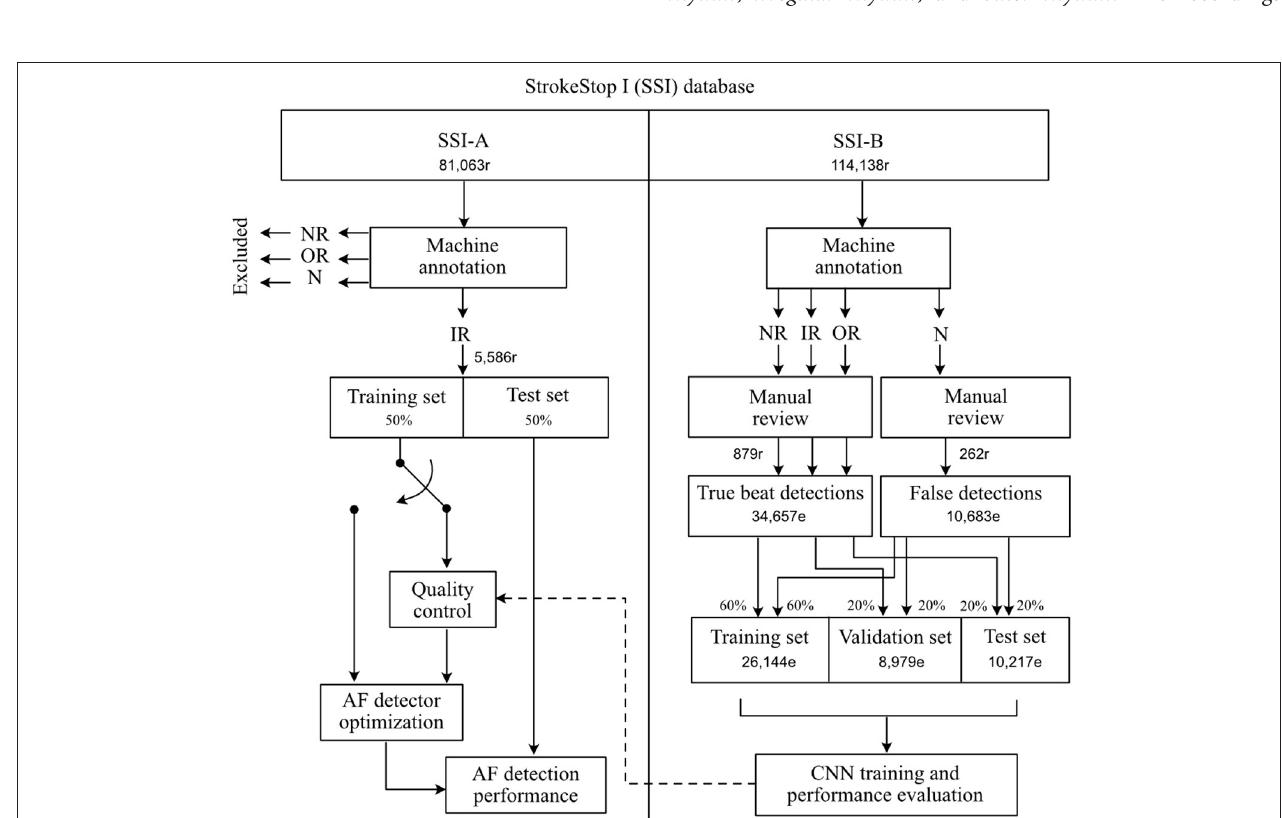
FIGURE 2 | Creation of datasets for CNN-based quality control and AF detection training and performance evaluation. The machine annotated categories normal rhythm , irregular rhythm , other rhythm , and noise are abbreviated to NR, IR, OR, and N, respectively. The number of recordings are indicated by an appended “r” and the number of events are indicated by an appended